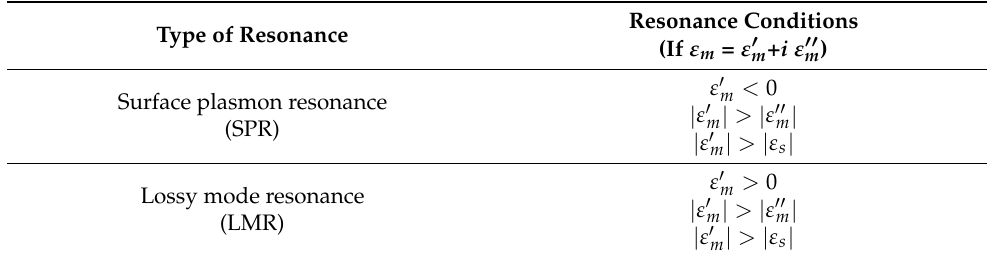
Table 1. Resonance condition for thin-film-coated optical waveguides, in which ε (cid:48) m and ε (cid:48)(cid:48) m denote the real and imaginary parts of coated material,